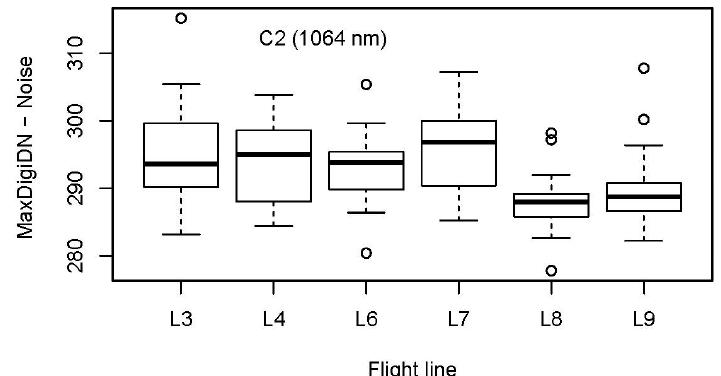
Figure 4. The boxplot showing maximum values (with subtracted noise) of the digitized fraction of